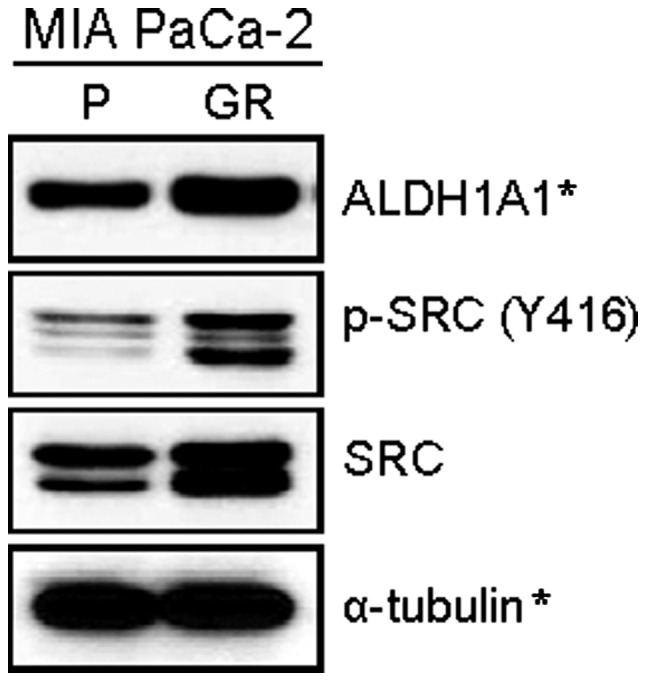
The level of phospho-SRC is higher in MIA PaCa-2/GR cells than in MIA PaCa-2/P cells. The western blot analysis of exponentially growing cells determined the level of the total and phosphorylated forms of SRC (Y416). α-tubulin was used for a loading and transfer control. *Adopted from our previous report (20).